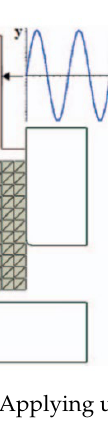
Figure 12. Applying ultrasonic vibration onto the plunger during the ECAP process reprinted from ref. [46]. Copyright 2022 ELSEVIER.